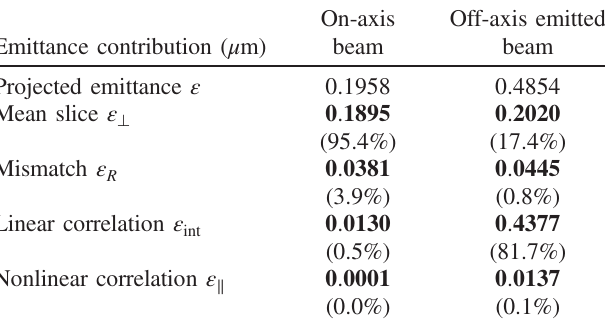
TABLE III. Decomposition of the vertical projected emittance for a beam emitted on-axis and for a beam emitted 2 mm off-axis, evaluated at the exit of the photoinjector beam line shown in Fig. 1. The percentage contribution of each term to the sum in quadrature (12) is also given. Space charge is turned